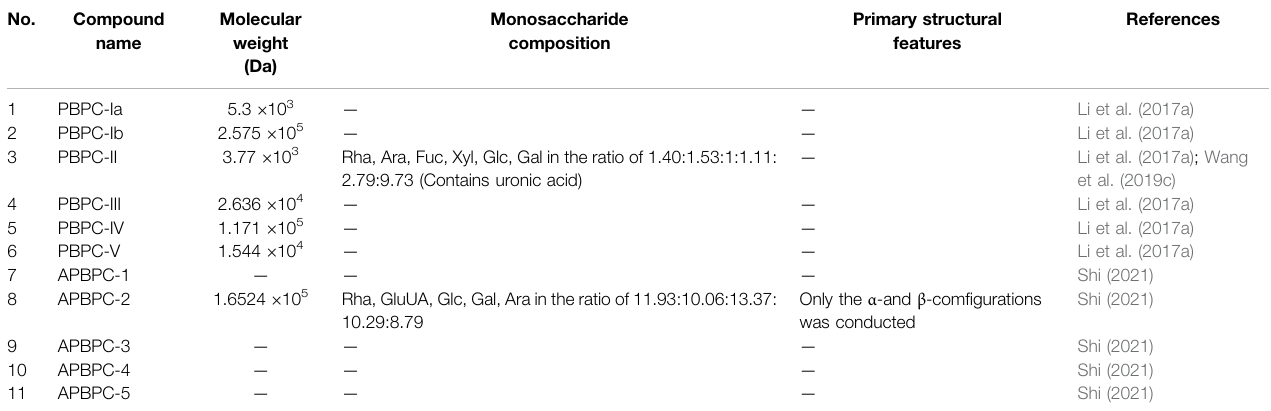
TABLE 3 | The polysaccharides isolated from bee pollen of saf fl ower: chemical structure.